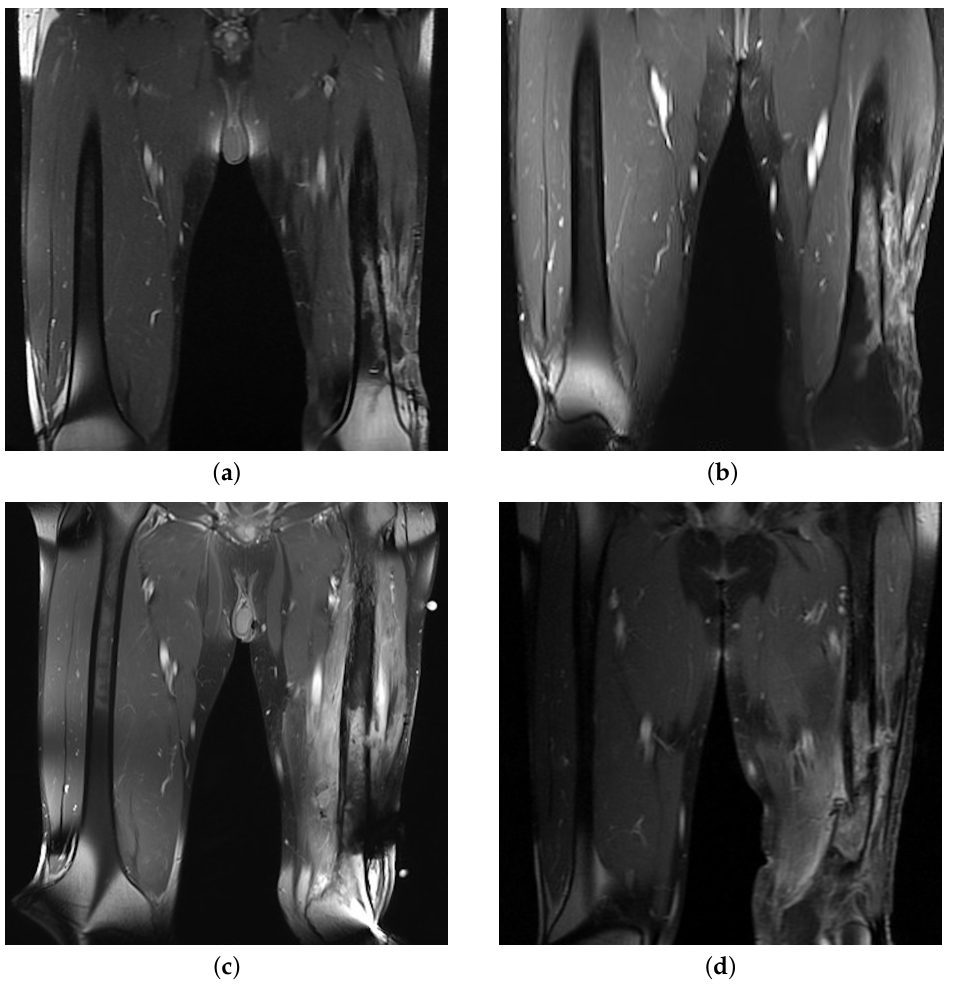
Figure 3. ( a ) Contrast-enhanced T1-weighted image over a 21-month follow-up after RT revealing soft tissue inflammation, bone marrow edema, and skin breakdown with sinus drainage. ( b ) MRI 3.5 years after RT, revealing lesion expansion. ( c ) MRI 4 years after RT, revealing severe tissue inflammation on the medial and lateral thigh, bone marrow edema, and one cortical defect in the left lateral femoral shaft. ( d ) MRI 4.5 years after RT revealing a pathological fracture of the left femoral